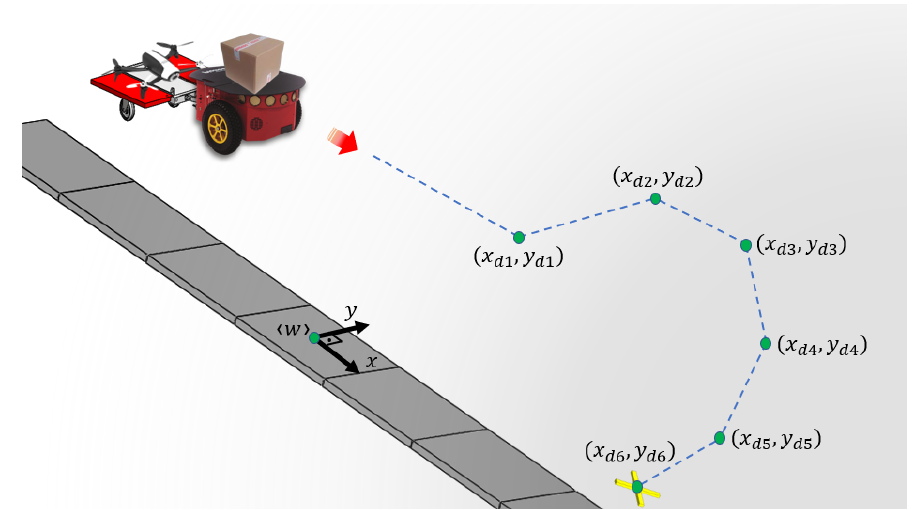
Figure 5. Sequence of